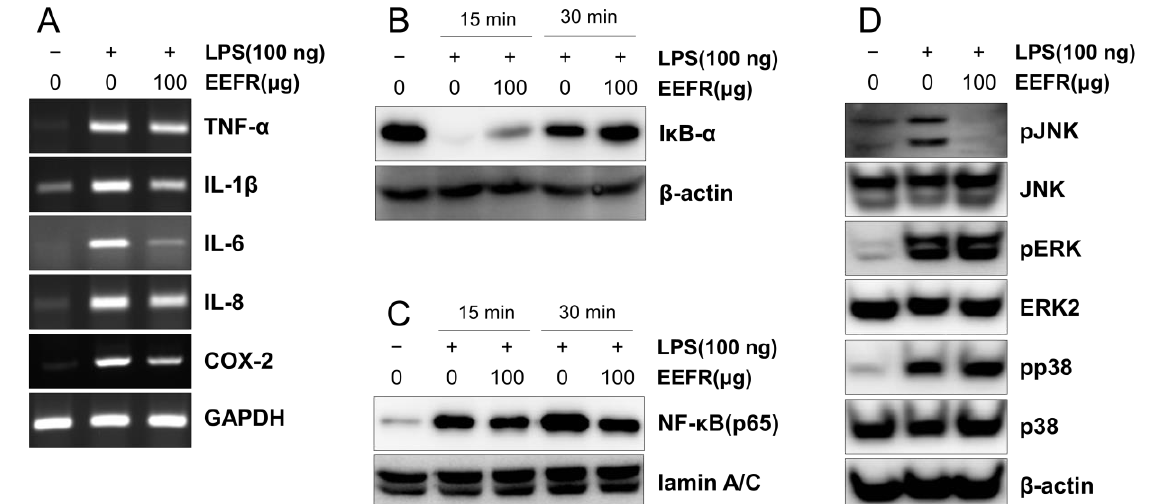
Figure 7. Effects of EEFR on LPS-induced increases on the expression of pro-inflammatory cytokines and COX-2, and on the NF-κB and MAPK signalling pathways in RAW 264.7 cells. Pro-inflammatory cytokine, chemokine, and COX-2 expressions were assessed with RT-PCR ( A ). Levels of IκB-α in cytoplasm ( B ), p65 in nuclear fractions ( C ), and MAPK signalling molecules ( D ) were determined using Western blots.